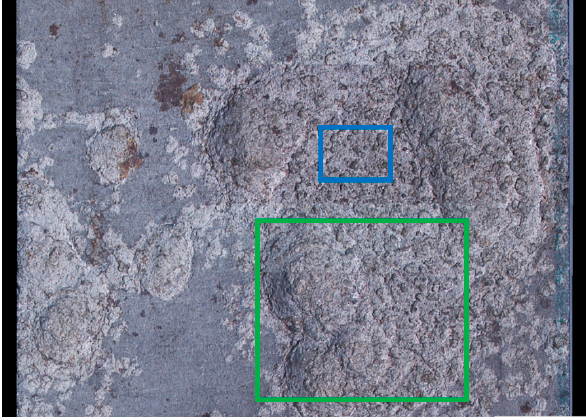
Figure 8. ( a ) High levels of pitting; ( b ) Low levels of pitting; ( c ) Crevice corrosion under marine tape.